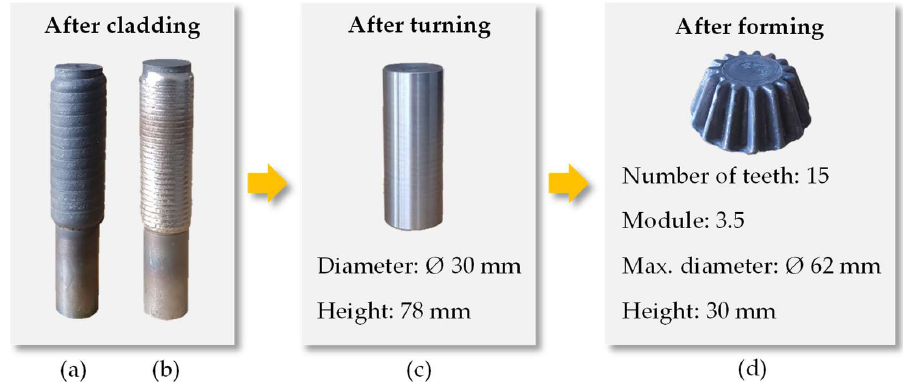
Figure 1. Cladded preforms produced with plasma transferred arc deposition welding (PTAW) ( a ) and laser hotwire cladding (LHC) ( b ) using a substrate with a diameter of 27 mm; geometry of the turned workpiece ( c ) and bevel gear ( d ).